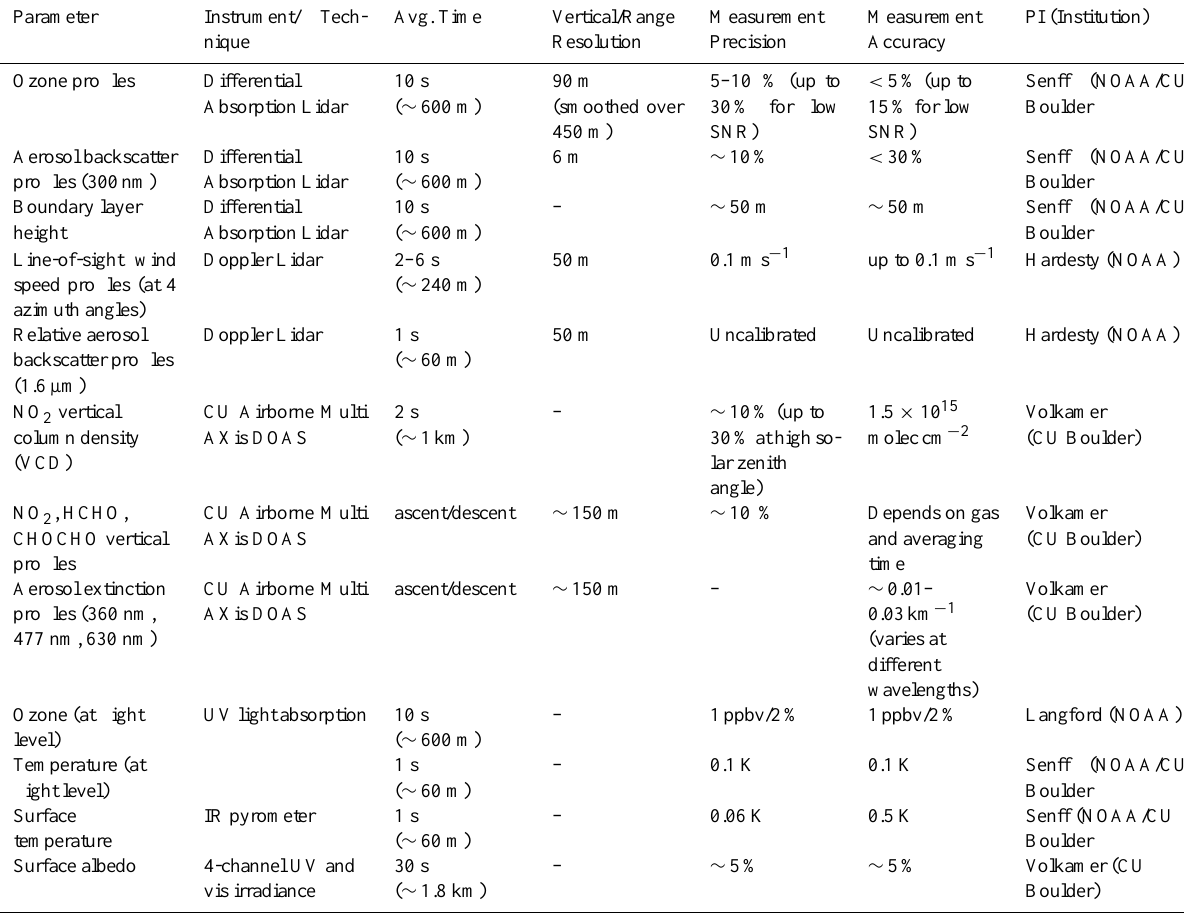
Table 4. Measurements and Instruments aboard the NOAA Twin Otter Aircraft during CARES 2010.